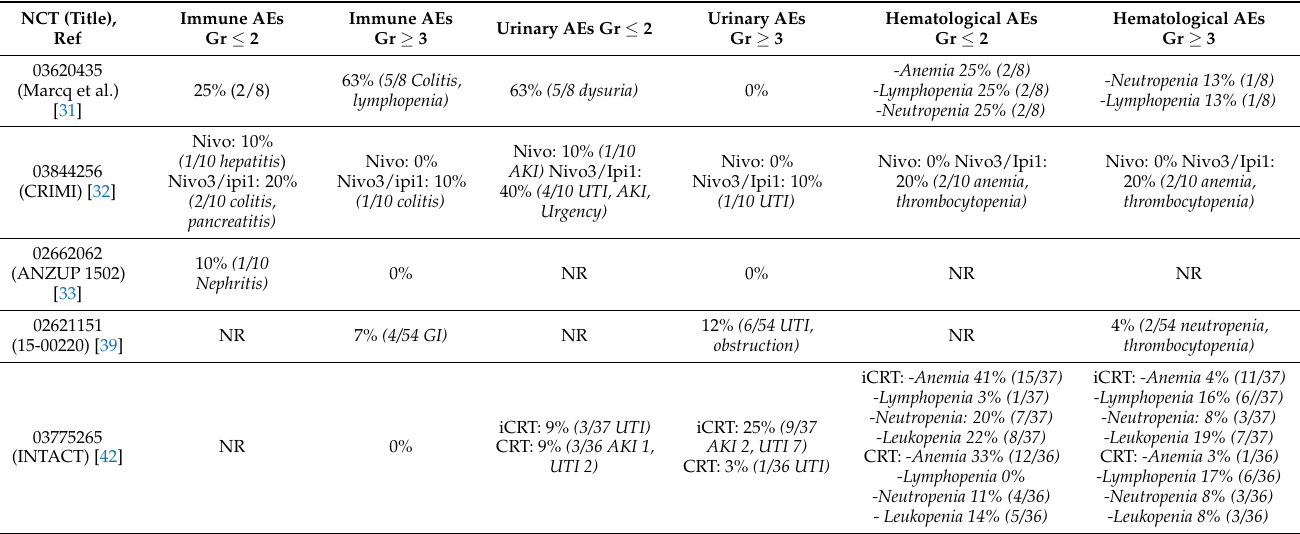
Table 3. Reported immune-mediated, urinary tract, and hematological adverse